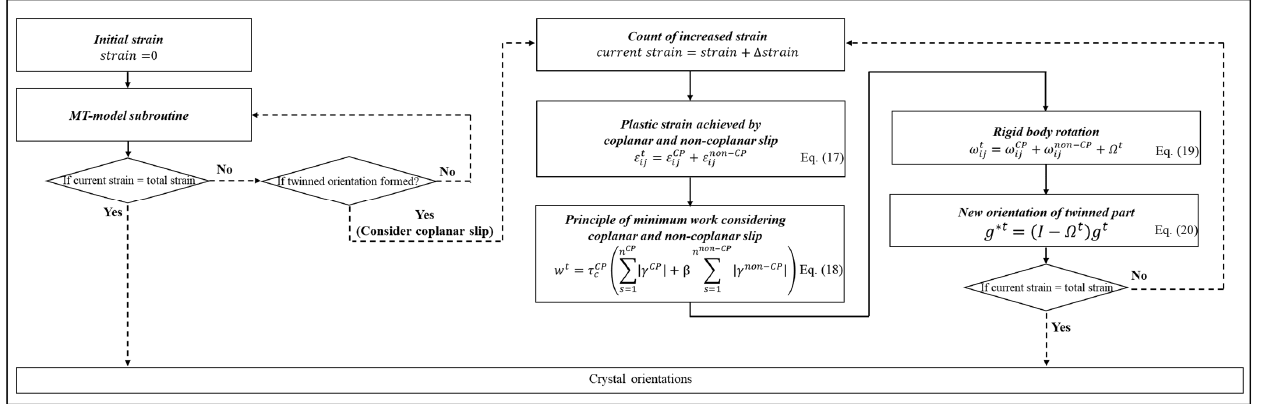
Figure 2. Flowchart of subroutine in MTCS-model.